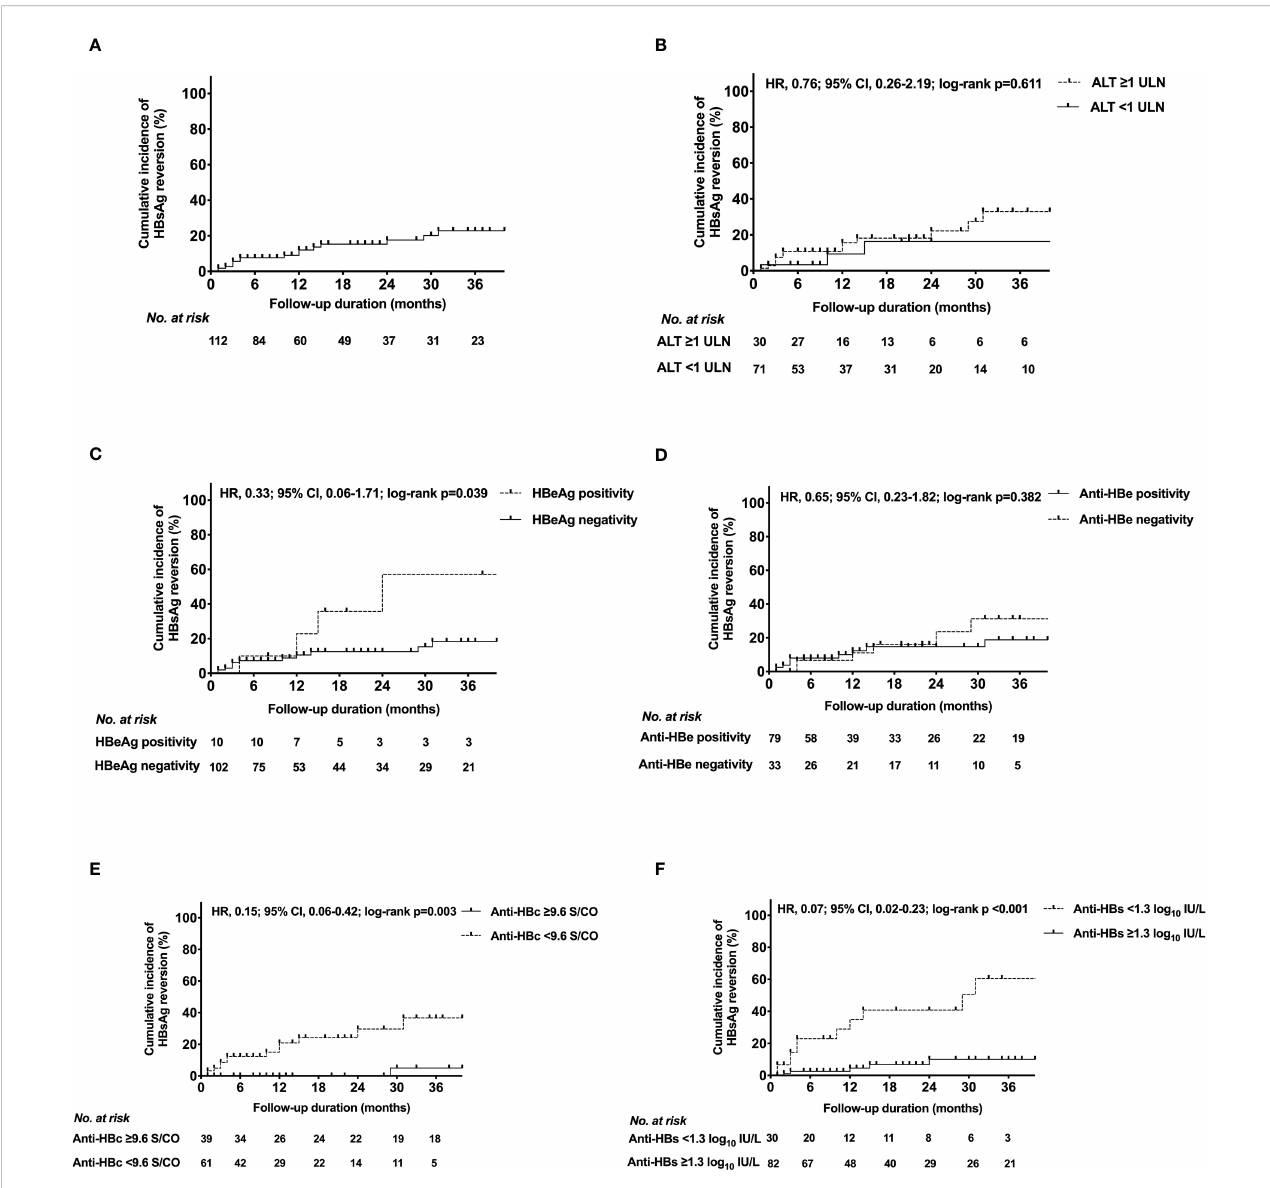
FIGURE 2 Kaplan-Meier estimates of cumulative incidence of HBsAg reversion in (A) the entire population, patients with different (B) ALT levels, (C) HBeAg status, (D) anti-HBe status, (E) anti-HBc level, (F) anti-HBs level at EOT. HBeAg, hepatitis B e antigen; HBsAg, hepatitis B surface antigen; Anti-HBs, hepatitis B surface antibody; Anti-HBc, hepatitis B core antibody; Anti-HBe, hepatitis B e antibody; ALT, alanine transaminase; ULN, upper limit of normal; HRV, hazard ratio; CI, con fi dence interval; EOT, end of PEG-IFN